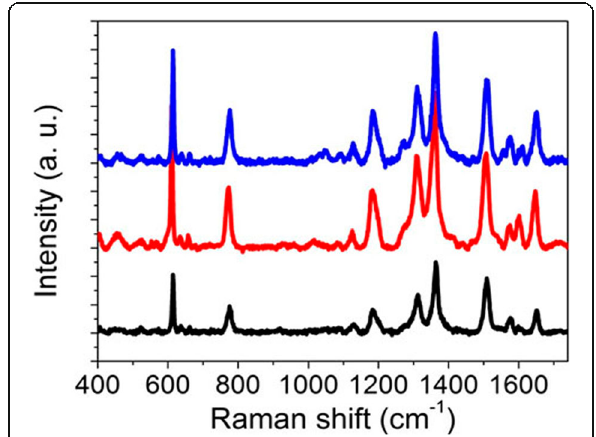
Fig. 9 Raman spectra of dual-layer porous Au film structures fabricated at 180, 200, and 220 °C. Laser power: 0.24 mW